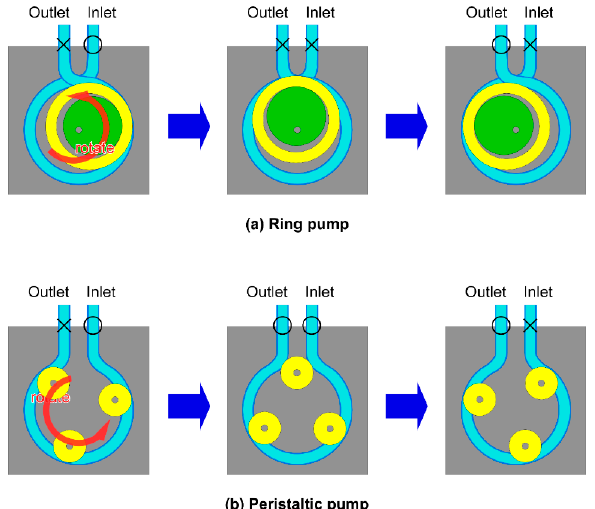
Figure 2. Schematic drawing showing prevention of backflow of liquid. ( a ) If the tube of the RP is crossed at the entrance and exit of the pump, there is no time interval when the inlet and the outlet are opened simultaneously. The yellow roller is always pressing one or the other openings closed. ( b ) If the tube of the PP is not crossed, there is a time interval when the inlet and the outlet are opened simultaneously (center image) and backflow can occur.